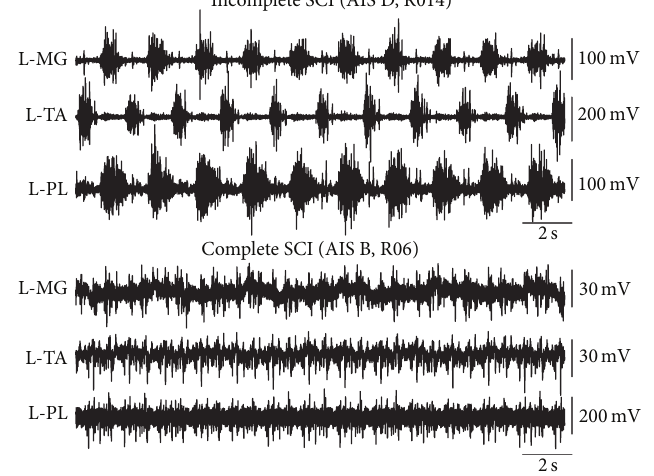
Figure 6: Motor activity after locomotor training in incomplete and complete SCI. Nonrectified electromyographic (EMG) activity from 10 consecutive steps of medialis gastrocnemius (MG), tibialis anterior (TA), and peroneus longus (PL) muscles from the left legs in one motor incomplete SCI subject (AIS D) and in one motor complete SCI subject (AIS B) during assisted stepping after locomotor training. Note in subject R014 that MG and PL occur in a reciprocal pattern with the TA, but distinctive EMG bursts are absent in subject